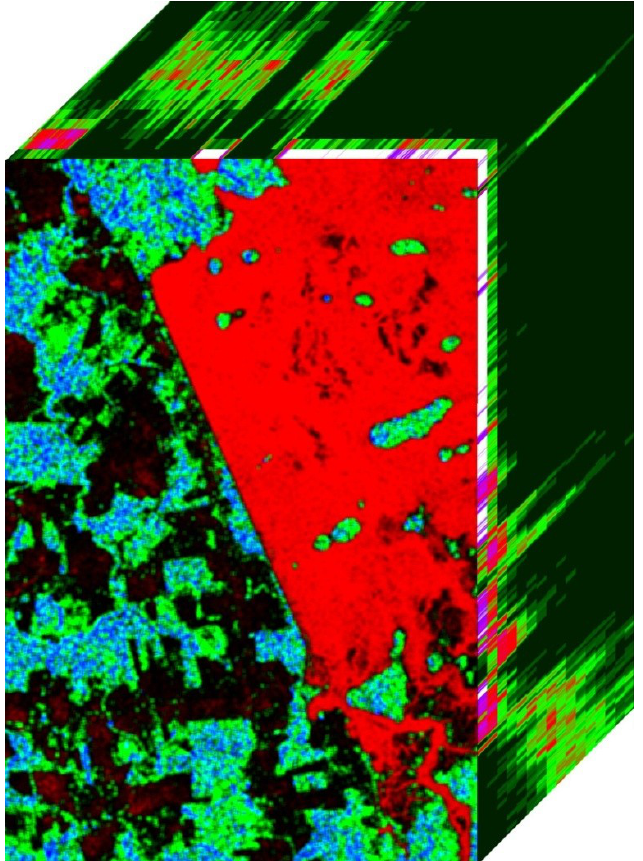
Figure 5. 3D image cube composed of probability density components (PDCs), where a cube face is an RGB color composition (1PDC, 8PDC and